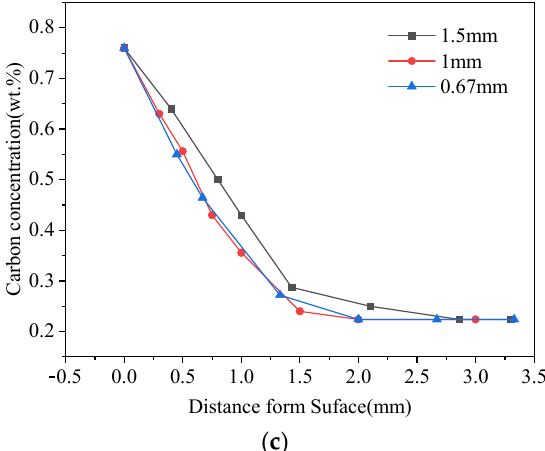
Figure 2. ( a ) Helical gear three-dimensional model; ( b ) restrictive conditions; and ( c ) simulation value of carbon concentration.